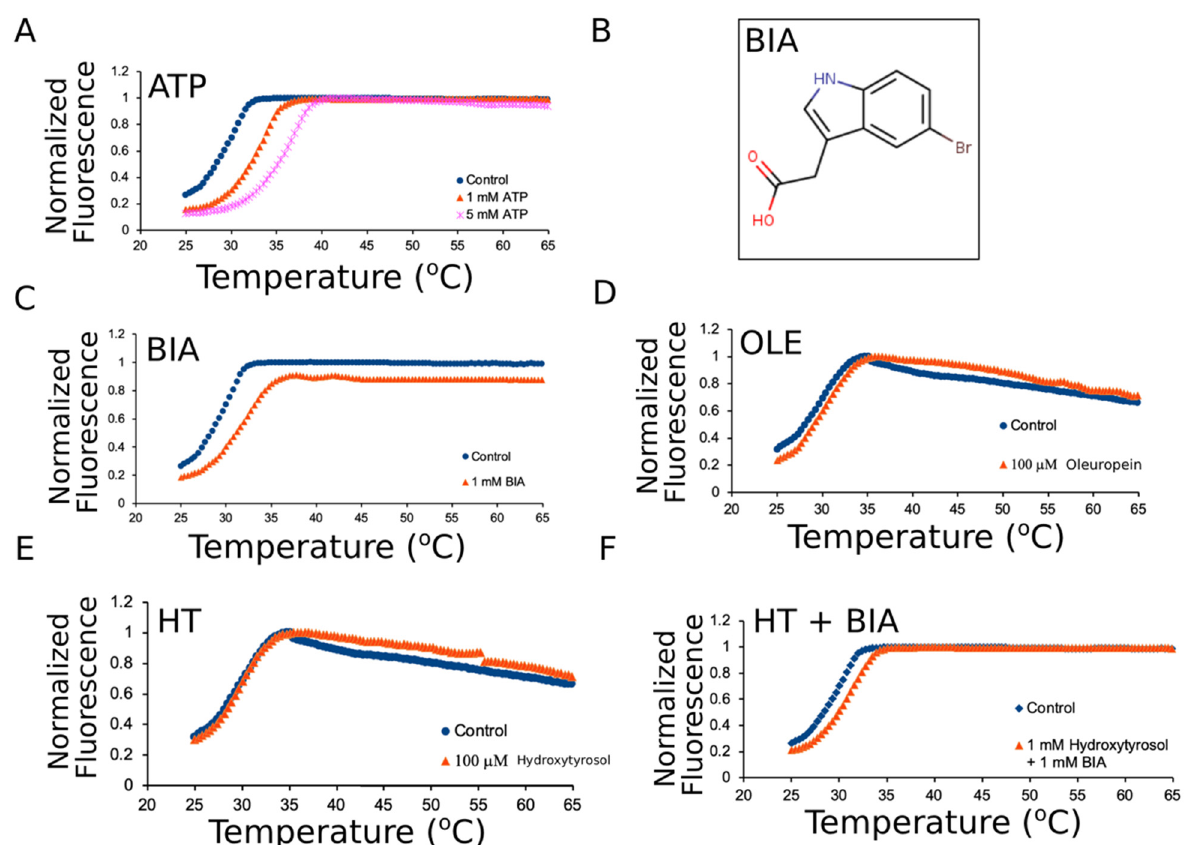
Figure 2. Oleuropein and Hydroxytyrosol do not affect thermal stability of mNBD1- ∆ F508. ( A ) mNBD1- ∆ F508 thermal stability measured in absence (blue), or presence of 1 mM or 5 mM ATP (orange or pink) using differential scanning fluorimetry, p -value = 0.00275 and 0.00006, respectively. ( B ) Structure of 5- bromoindole -3-acetic acid (BIA) compound used in experiments. ( C ) mNBD1- ∆ F508 thermal stability measured in absence (blue), or presence of 1 mM BIA (orange), p -value = 0.03006. ( D ) mNBD1- ∆ F508 thermal stability measured in absence (blue), or presence of 100 µ M Oleuropein (orange), p -value = 0.6167. ( E ) mNBD1- ∆ F508 thermal stability measured in absence (blue), or presence of 100 µ M Hydroxytyrosol (orange), p -value = 0.7999. ( F ) mNBD1- ∆ F508 thermal stability measured in absence (blue), or presence of 1 mM Hydroxytyrosol and 1 mM BIA (orange), p -value = 0.02076. Representative curves presented ( n = 3 and 3 replicates per experiment) and significant differences were analyzed by